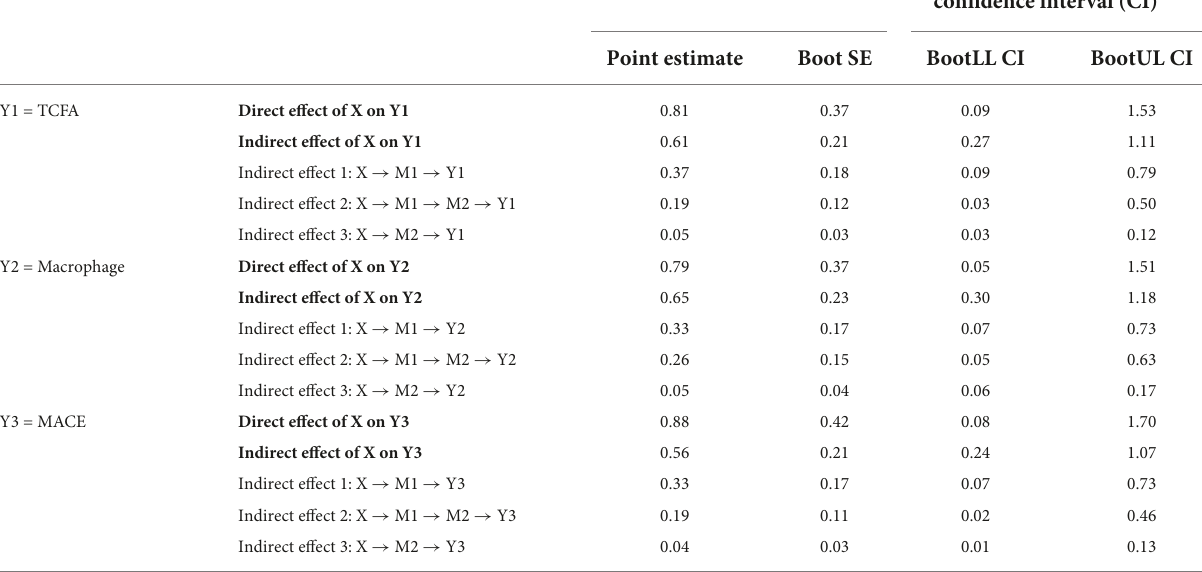
TABLE 5 The effects of Type D personality on plaque vulnerability and MACE mediated by inflammation and